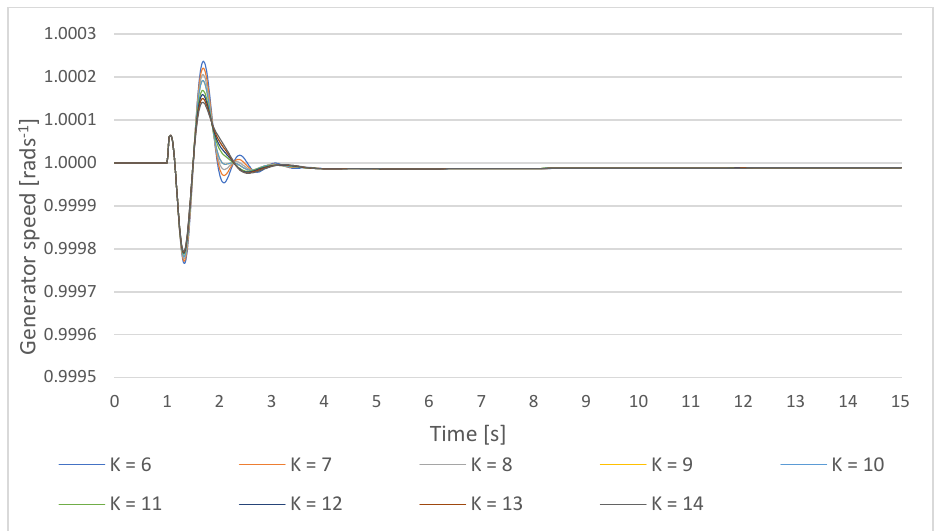
Figure 17. Gen1 speed response on a small disturbance with PSS parameters T = 0.5 s, the PSS gain increase in the lower cluster 1- K i,ln = 6 – 10, and the upper cluster 1 K i,um = 10 – 14.